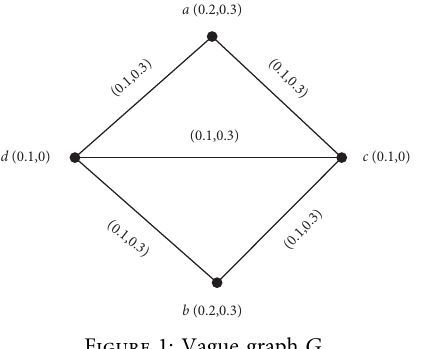
Figure 1: Vague graph G